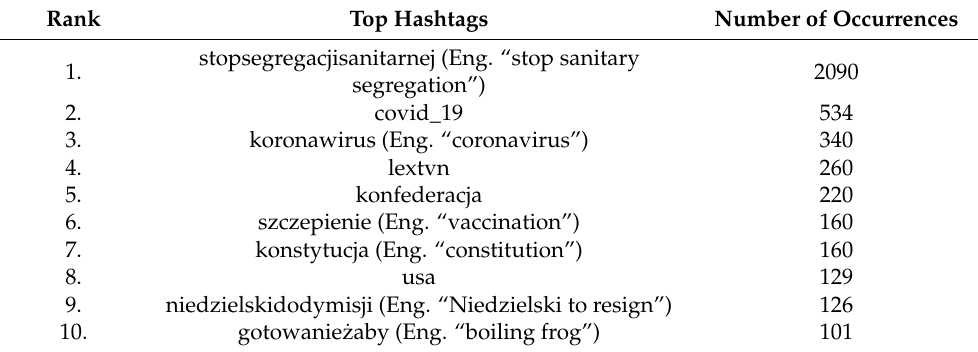
Table 2. Top 10 hashtags in the group